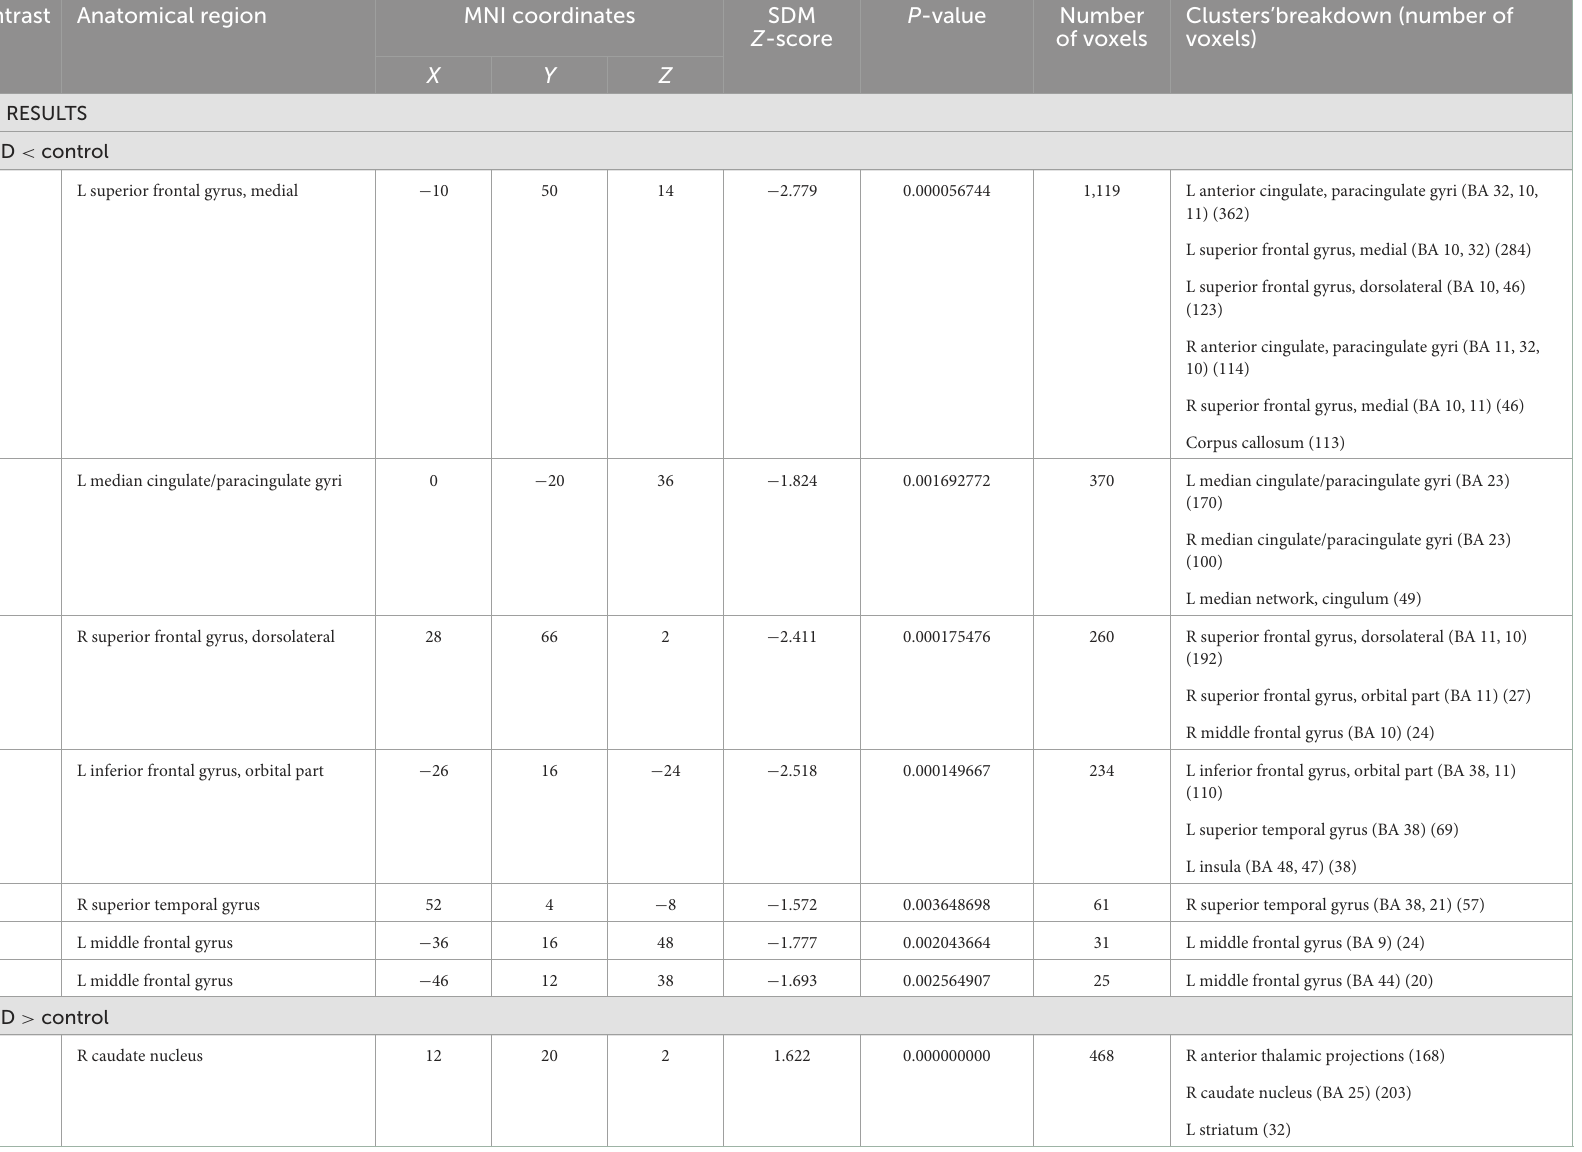
TABLE 5 Subgroup analysis results for voxel-based morphometry and fMRI studies in ADHD (pediatrics group). Contrast Anatomical region MNI coordinates SDM